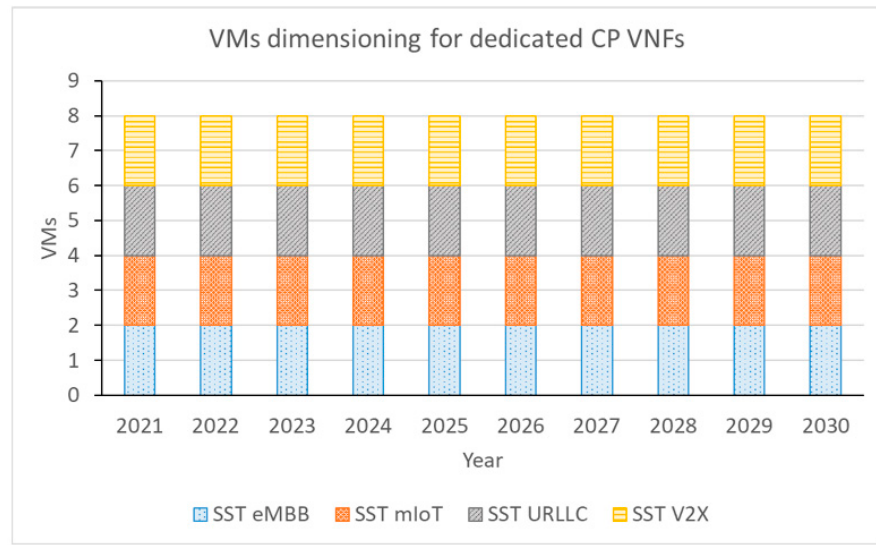
Figure 6. VMs dimensioning for dedicated CP VNFs.